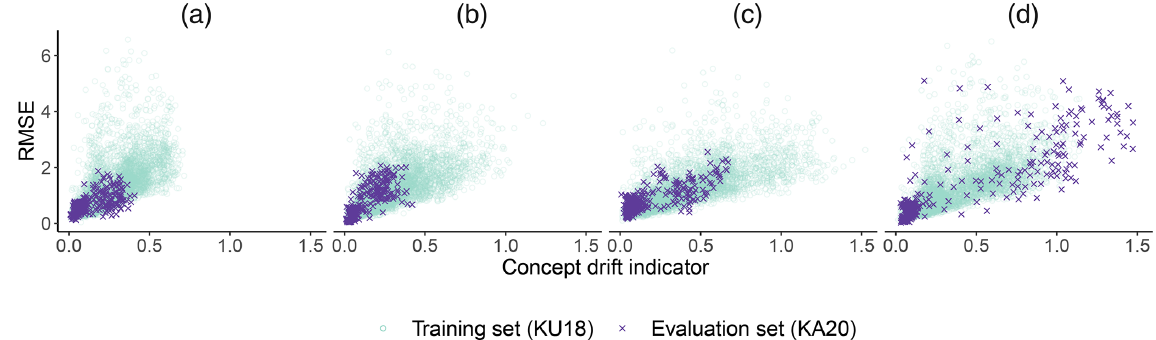
Figure 7. The relationship between the concept drift indicator and observed RMSE in a given segment in KU18 (circles) and KA20 (crosses) with (a) log-linear regression, (b) logarithmic support vector regression, (c) Gaussian process and (d) log-linear regression with all features used as the complete model. The opacity of the training data has been reduced by 80% to make the figure clearer.